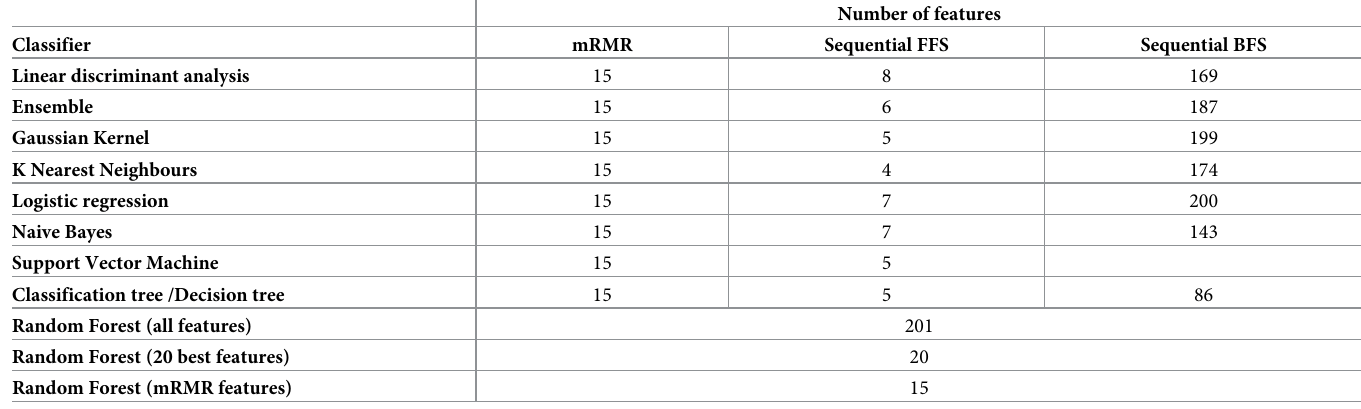
Table 3. Number of selected features with different classification and feature selection